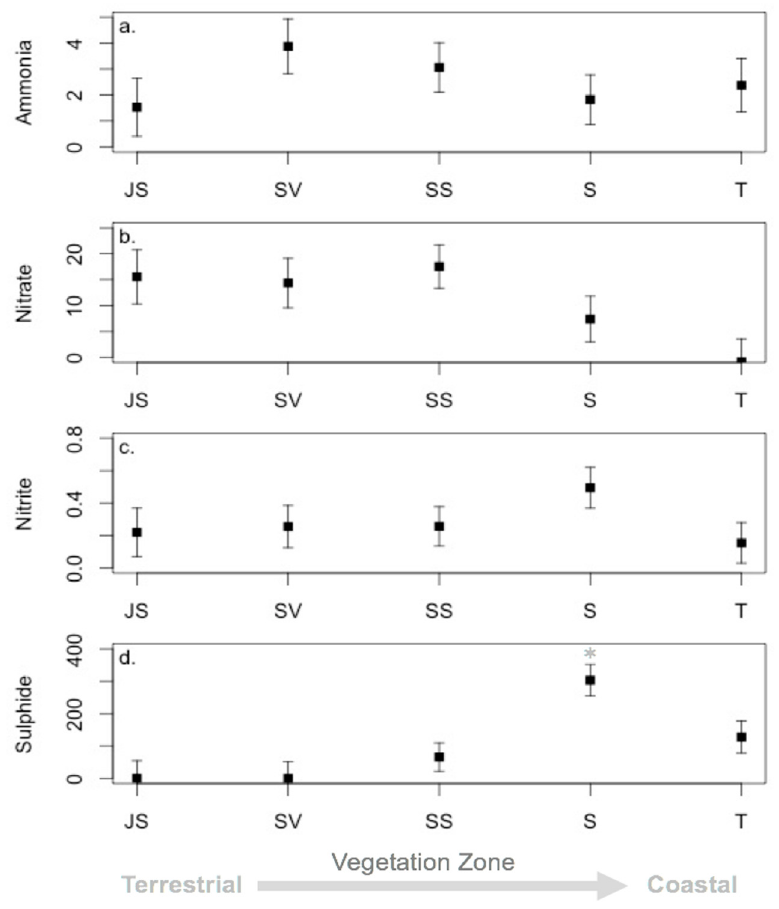
Figure 9. Sediment chemistry least square means by vegetation zone. ( a ) Ammonia; ( b ) nitrate; ( c ) nitrite, and ( d ) sulphide. (JS = high marsh Juncus roemerianus ; S = low marsh short form S. alterniflora ; SV = high marsh Salicornia virginica ; SS = mid ‐ marsh mixed zone of co ‐ occurring S. virginica and short form Spartina alterniflora ; T = low marsh tall form S. alterniflora ). Asterisks (*) denote significant differences between vegetation zones and error bars denote standard errors.